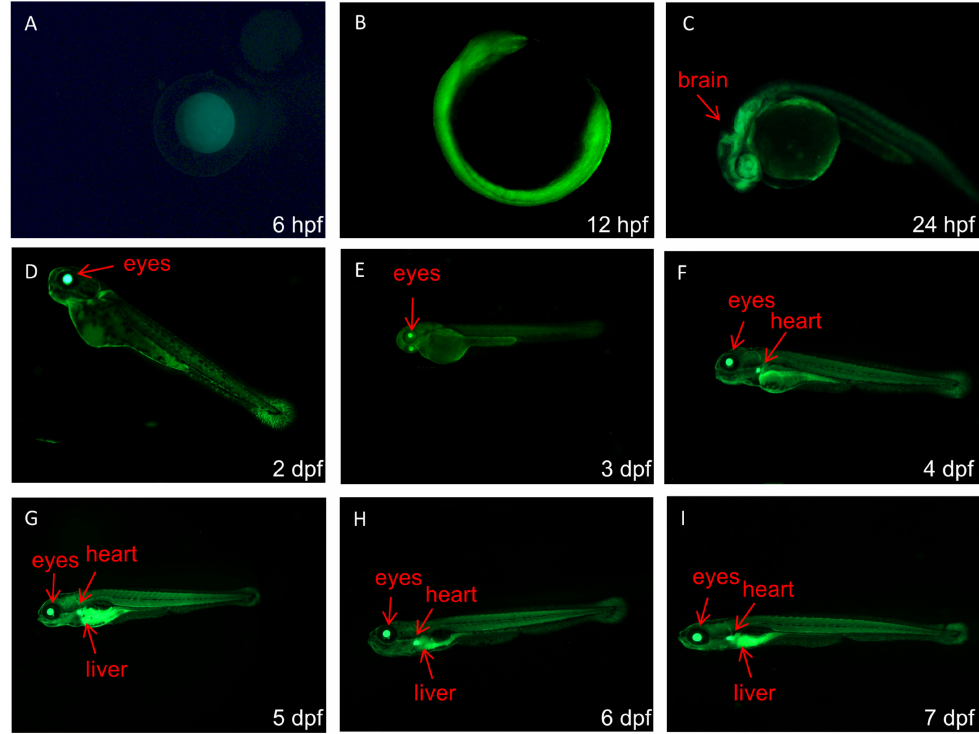
Figure 2. GFP expression patterns in the EYE line generated by the PB -mediated enhancer trap. ( A – I ) nine developmental stages. The arrows indicate GFP+